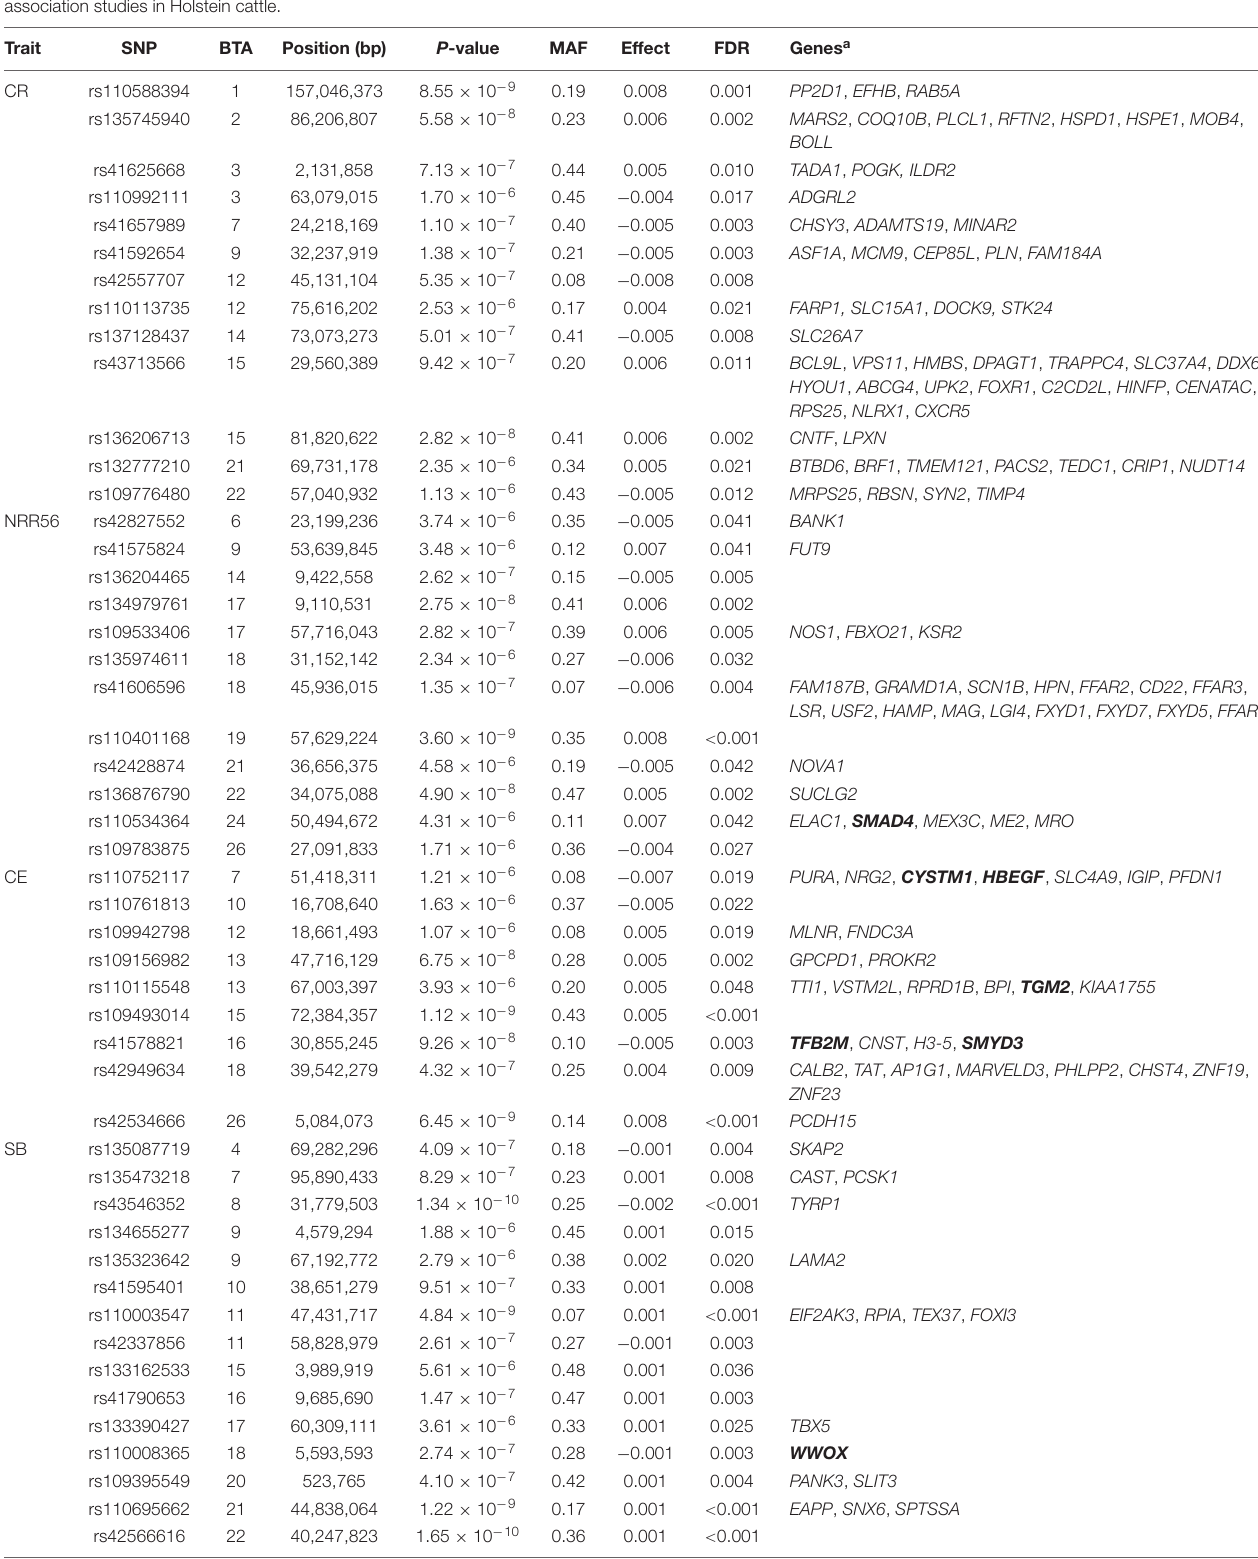
TABLE 5 | Significant single-nucleotide polymorphism (SNP) and near-by genes of the genetic effects of dam on five reproductive traits carried out by genome-wide association studies in Holstein cattle. Trait